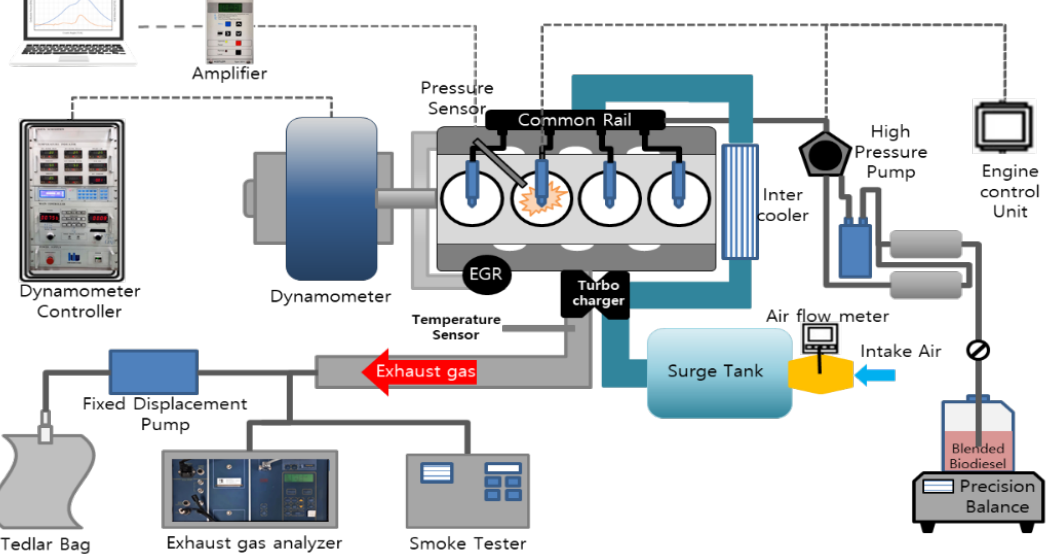
Figure 1. Schematic diagram of the experimental setups.